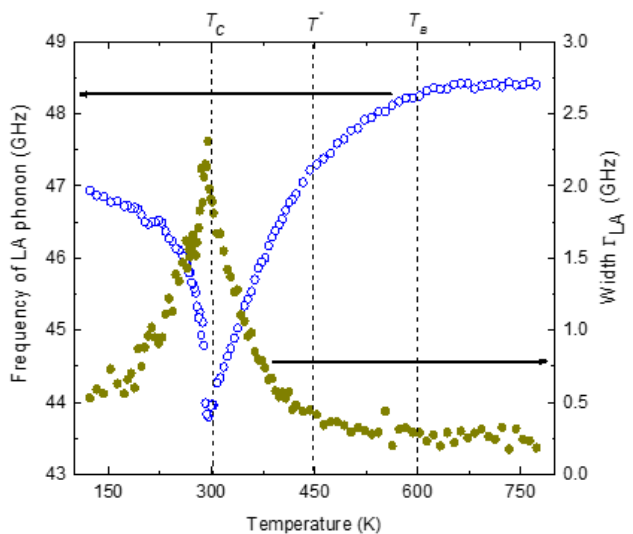
Figure 10. Temperature variation in frequency (open circles) and the width(closed circles) of the LA phonon of PST.